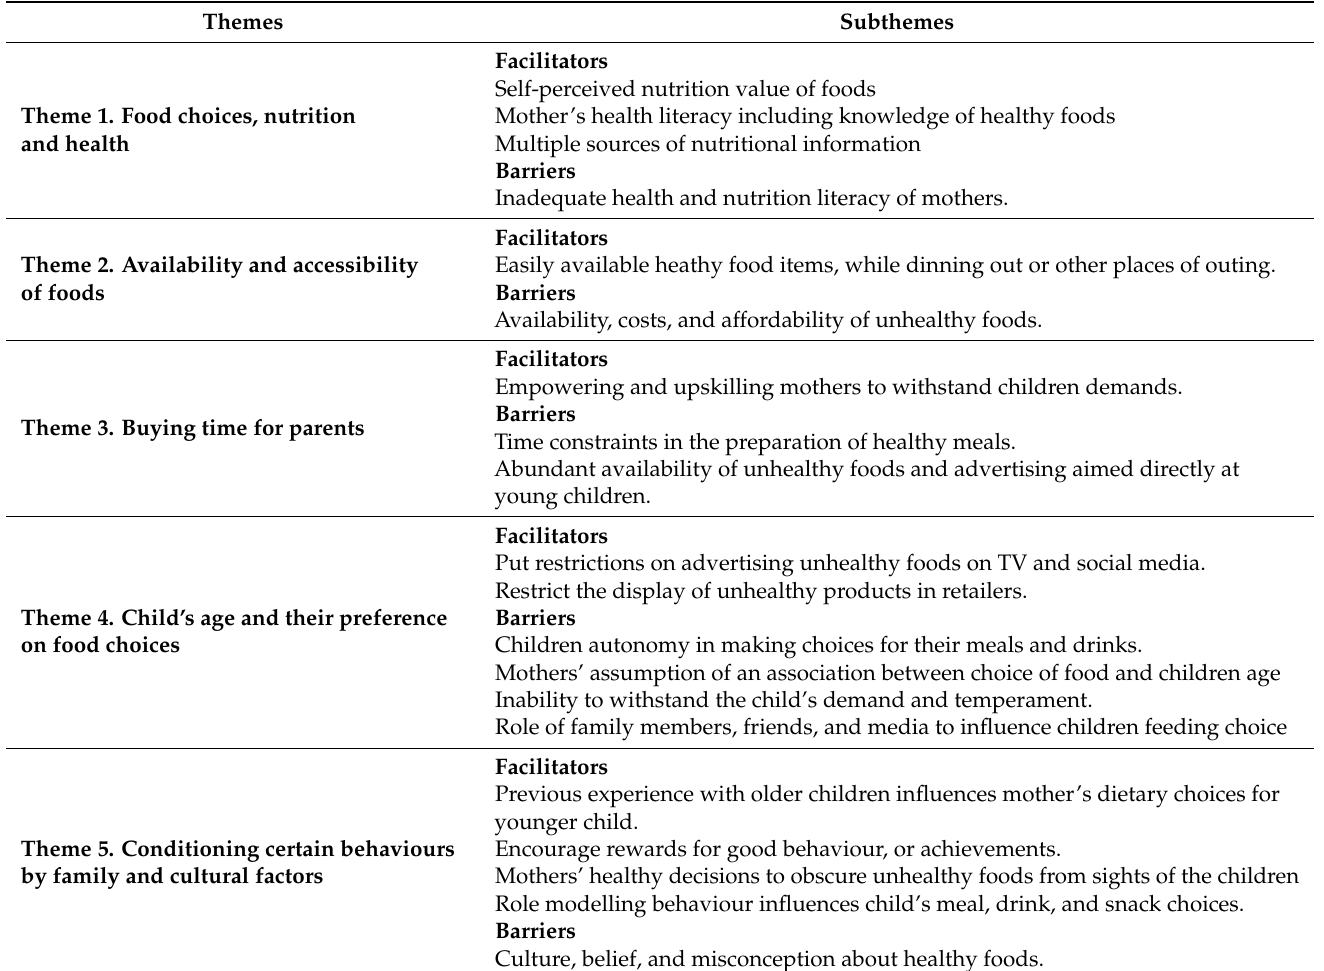
Table 3. Summary of themes with facilitators and barriers segregated